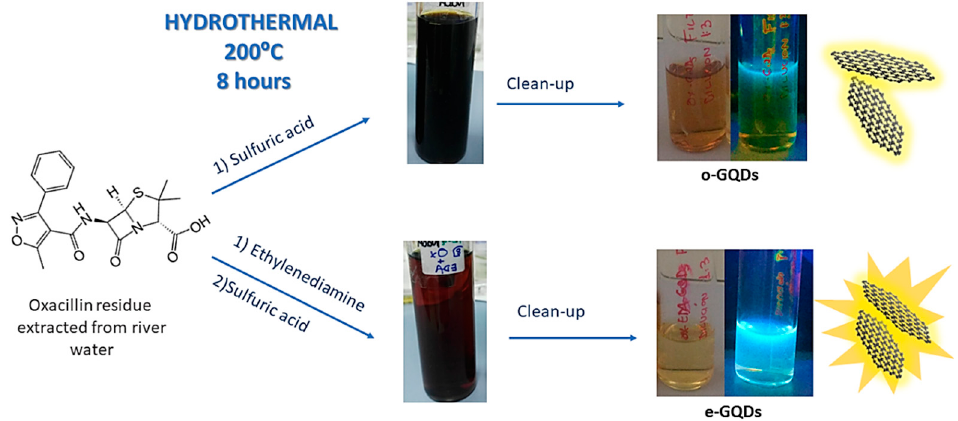
Figure 1. Schematic representation of the synthetic procedure of graphene nanostructures from oxacillin residues recovered from water samples. Pictures of graphene quantum dot (GQD) dispersions in water under sunlight (left) and UV lamp (right) irradiation are shown.